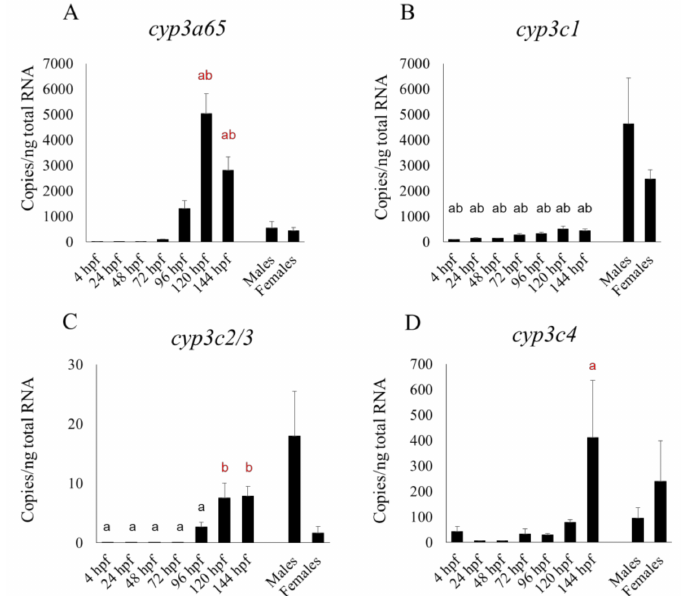
Figure 3. Developmental expression of four mRNA of cyp3 isoforms in zebrafish whole embryos and larvae from 4 to 144 h post-fertilization (hpf) in comparison with their expression in the livers of adults of both sexes. Results of cyp3a65 ( A ), cyp3c1 ( B ), cyp3c2 / 3 ( C ) and cyp3c4 ( D ) are shown. “a” indicates a significant ( p < 0.05) di ff erence compared with male livers and “b” is a significant ( p < 0.05) di ff erence compared with female livers. Black letters indicate significantly lower expression in embryos or larvae compared with adult livers, and red letters indicate significantly higher expression in embryos or larvae compared with adult livers. n =